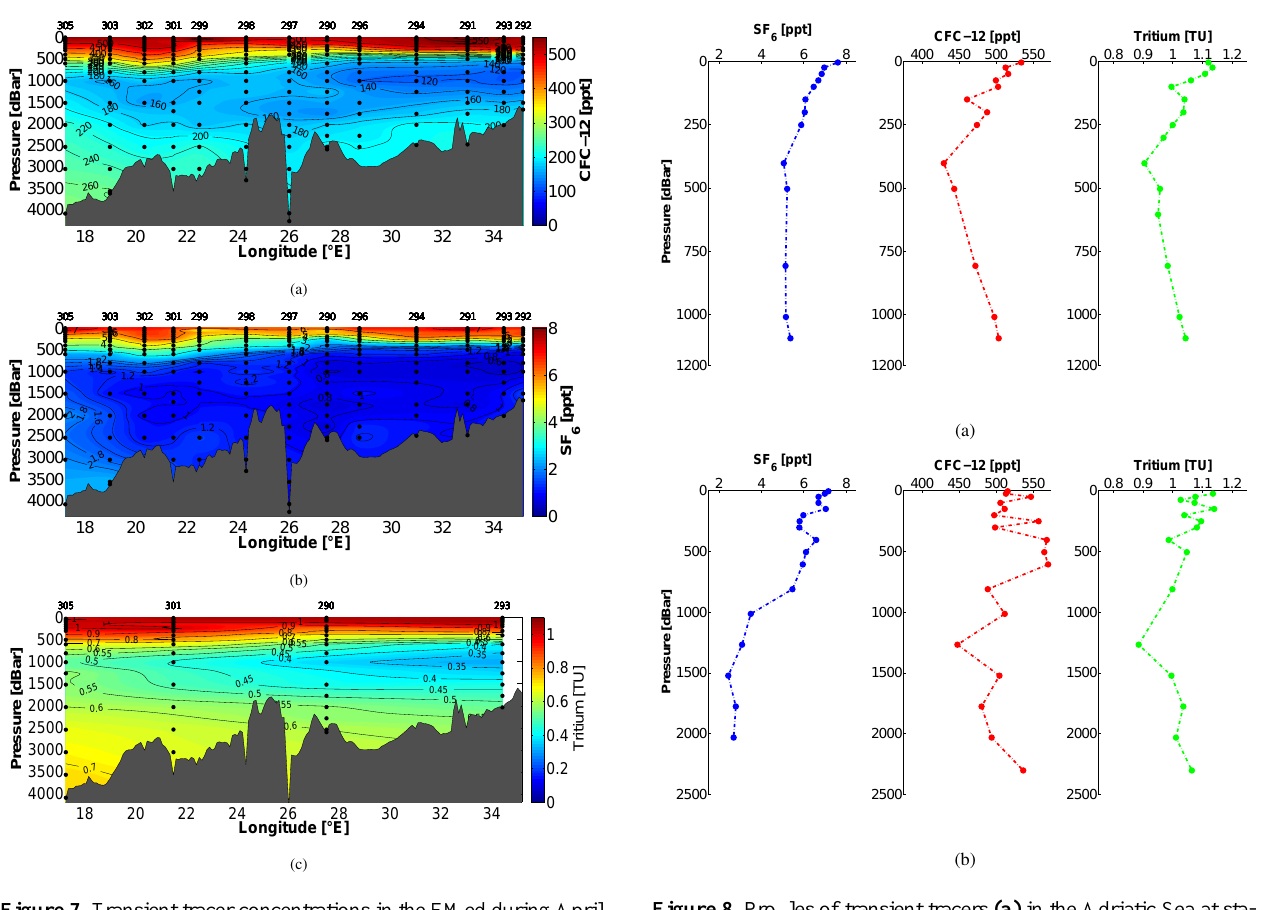
Figure 8. Profiles of transient tracers (a) in the Adriatic Sea at sta- Figure 7. Transient tracer concentrations in the EMed during April Fig. 7: Transient tracer concentrations in the EMed during April 2011 (cruise M84/3), red line in Fig. 6. ( a ) CFC-12 in ppt, ( b ) Fig. 8: Profiles of transient tracers ( a ) in the Adriatic Sea at station 313 and ( b ) in the Cretan Sea at station 288 during April tion 313 and (b) in the Sea of Crete at station 288 during April 2011. 2011 (cruise M84/3), red line in Fig. 6. (a) CFC-12 in ppt, (b) SF 6 SF 6 in ppt and ( c ) tritium in TU. 2011. All three transient tracer show high concentrations throughout the whole water column of the Adriatic Sea. The Cretan All three transient tracer show high concentrations throughout the Sea profiles show a clear concentration gradient for SF 6 whereas the CFC-12 and tritium concentrations scatter around their entire water column of the Adriatic Sea. The Sea of Crete profiles maximum values. show a clear concentration gradient for SF 6 , whereas the CFC-12 and tritium concentrations scatter around their maximum Table 2: Precision of CFC-12 and SF 6 measurements.